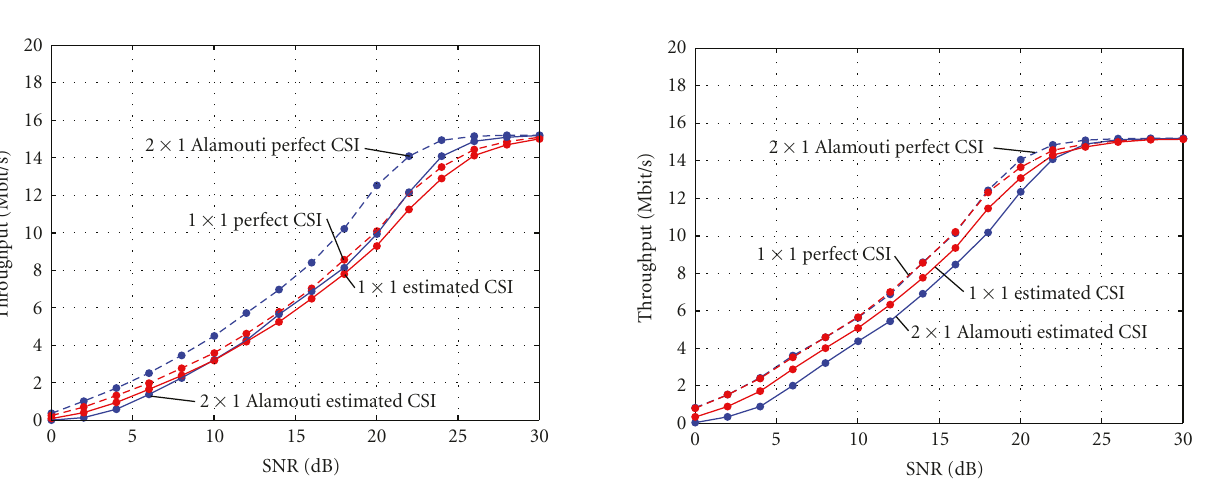
Figure 14: Simulated throughput performance for perfect and estimated channels, Pedestrian B channel model without spatial correlation.